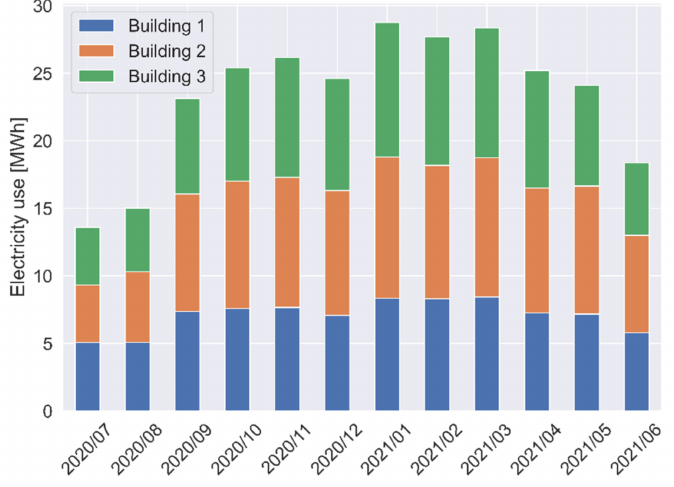
Figure 11. Monthly electricity use in the apartments for the three buildings of Testbed EM.